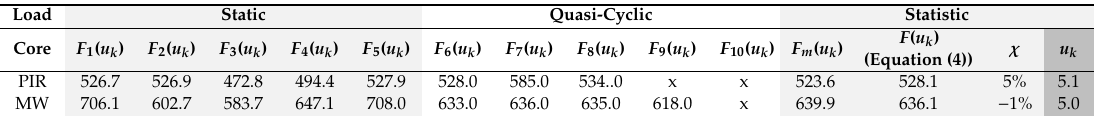
Table 9. Eccentric pull-out—comparison of the force from the laboratory tests: Fi(uk) (N), Fm(uk) (N) and the analytical calculations: F(uk)